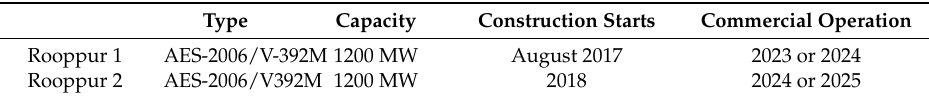
Table 1. Different sources of power and their heat